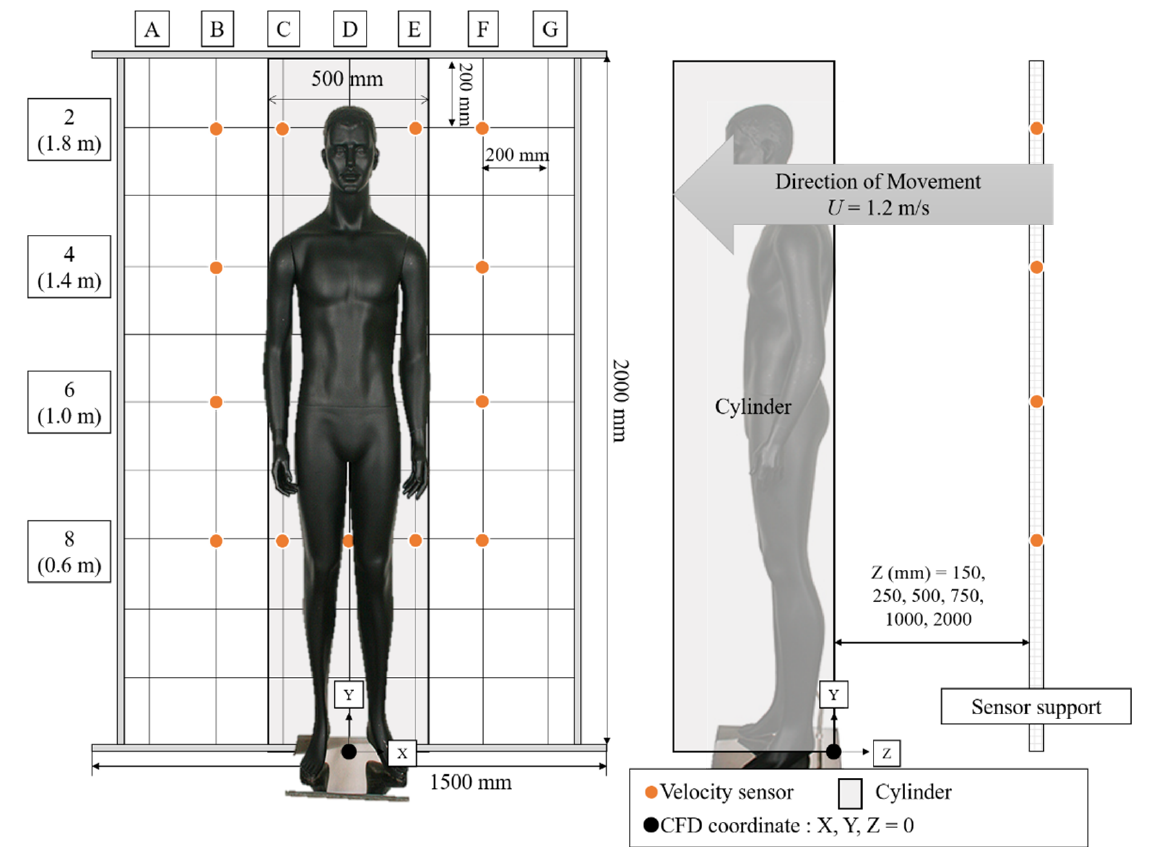
Figure 2. Schematic of the mobile wind velocity measurement system. Table 1. Locations of wind velocity measurement sensors.